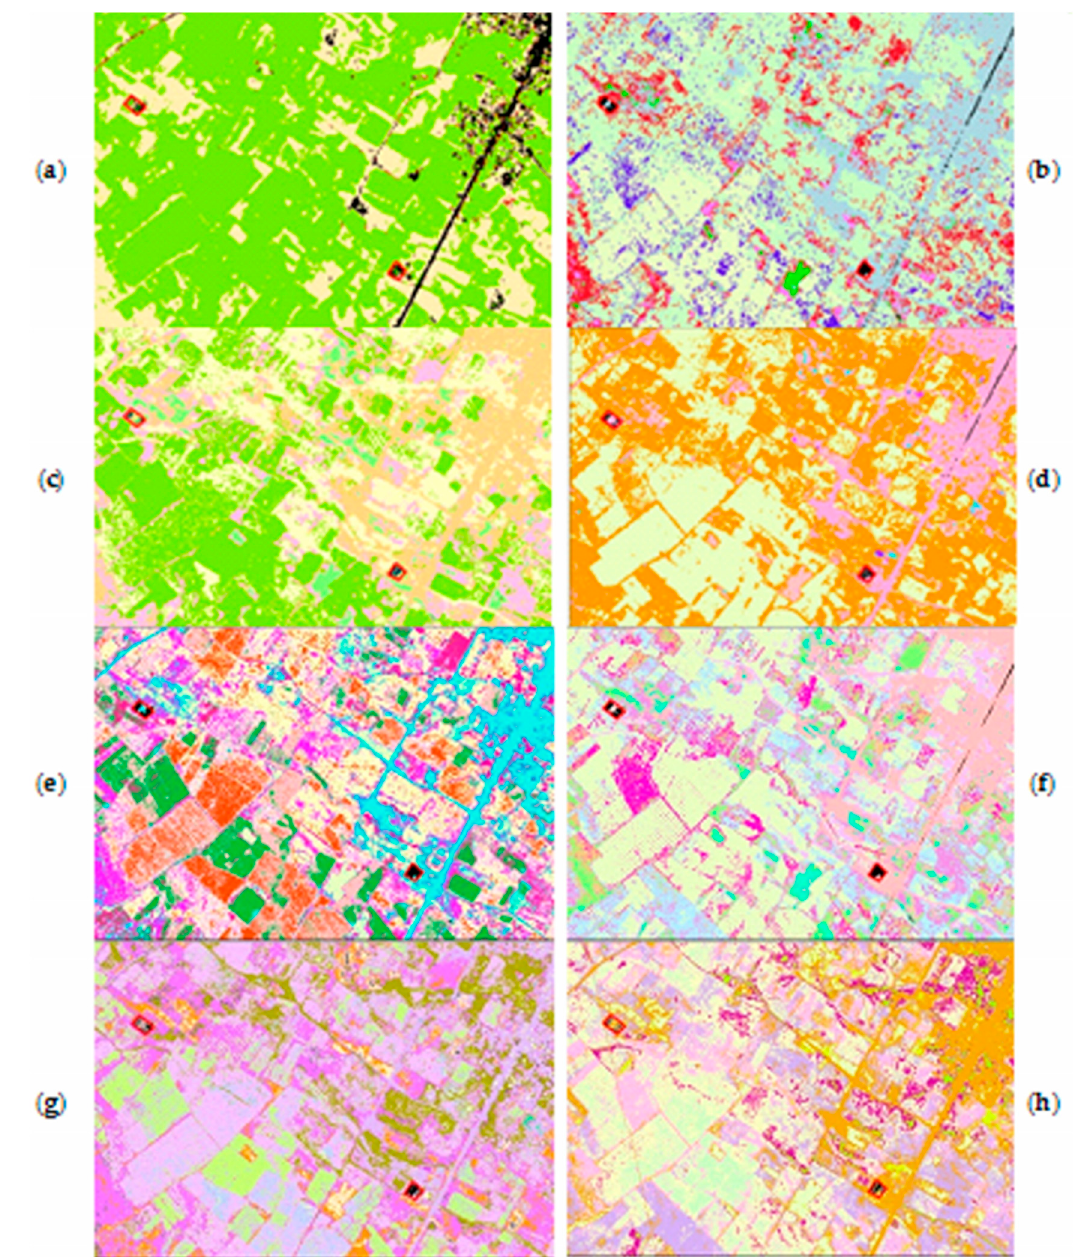
Figure 10. Maximum likelihood classification for Tunisian study areas; ( a ): ML classification using Sentinel-2 RGB image in February, ( b ): ML classification using Sentinel-2 RGB image in August, ( c ): ML classification using Sentinel-2 Composite 3 in February, ( d ): ML classification using Sentinel-2 Composite 3 in August, ( e ): ML classification using PlanetScope RGB image in February, ( f ): ML classification using PlanetScope RGB image in August, ( g ): ML classification using PlanetScope Composite 3 in February, ( h ): ML classification using PlanetScope Composite 3 in August; OMW disposal areas are indicated inside a red